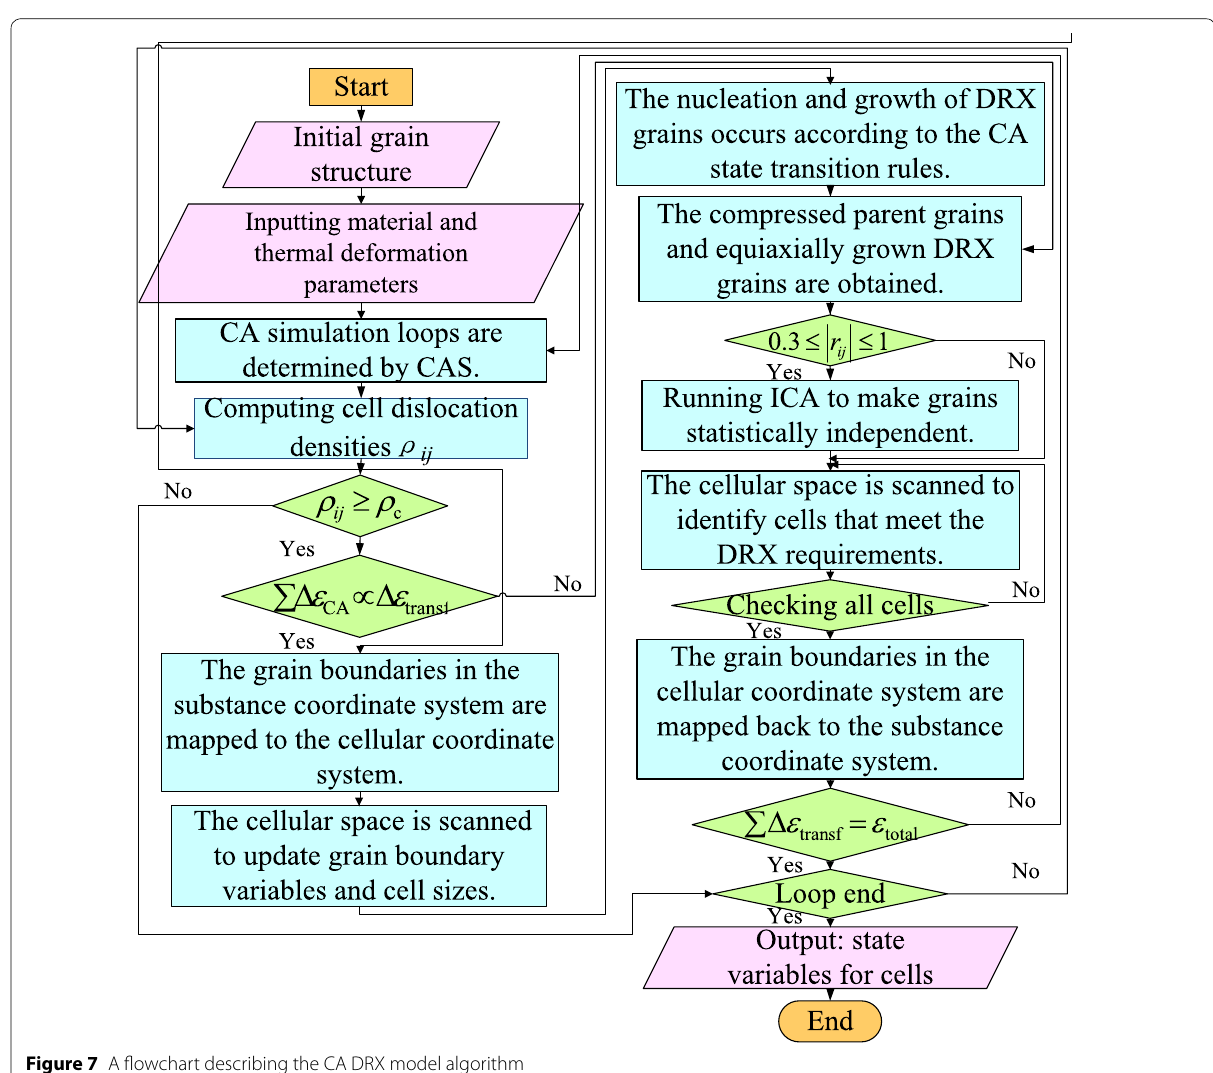
Figure 7 A flowchart describing the CA DRX model algorithm